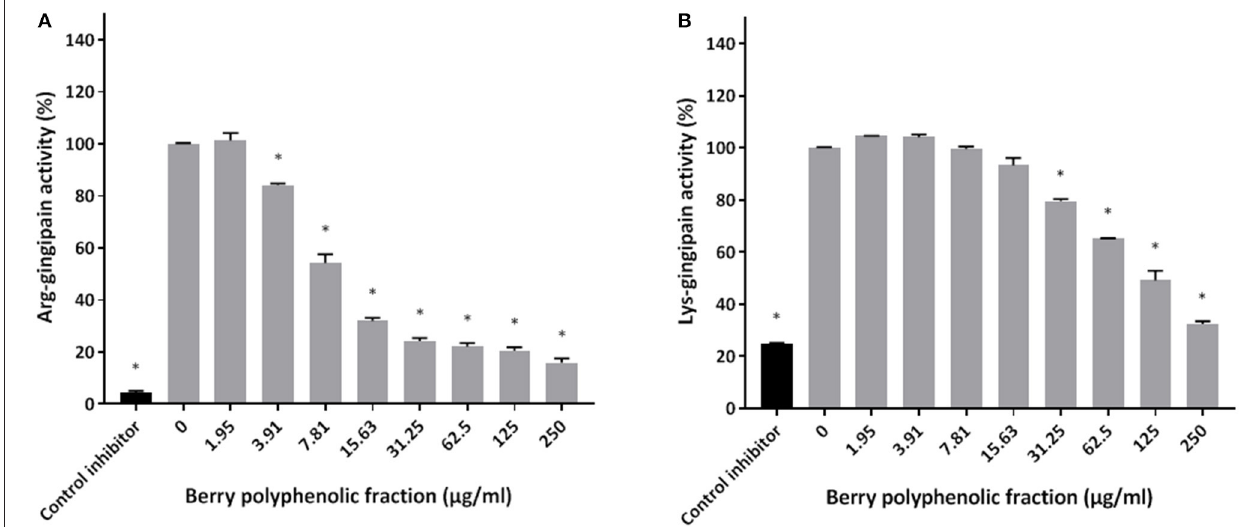
FIGURE 5 | Effect of the berry polyphenolic fraction on the Arg-gingipain activity (A) and Lys-gingipain activity (B) of P. gingivalis . Tosyl-L-lysine chloromethyl ketone hydrochloride was used as a control inhibitor. A relative value of 100% was assigned to the activity in the absence of the berry polyphenolic fraction. Results are expressed as the means ± SD of triplicate assays from three independent experiments. *Significant inhibition ( p < 0.01) compared to the control.